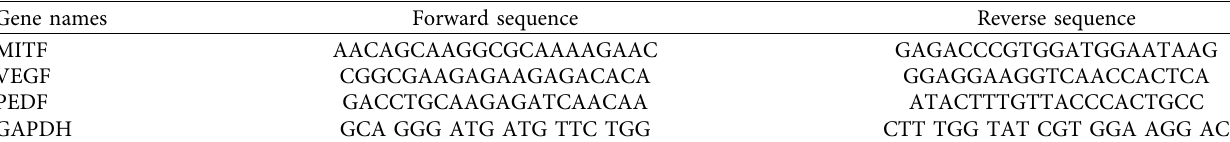
Table 1: Primers used for real-time